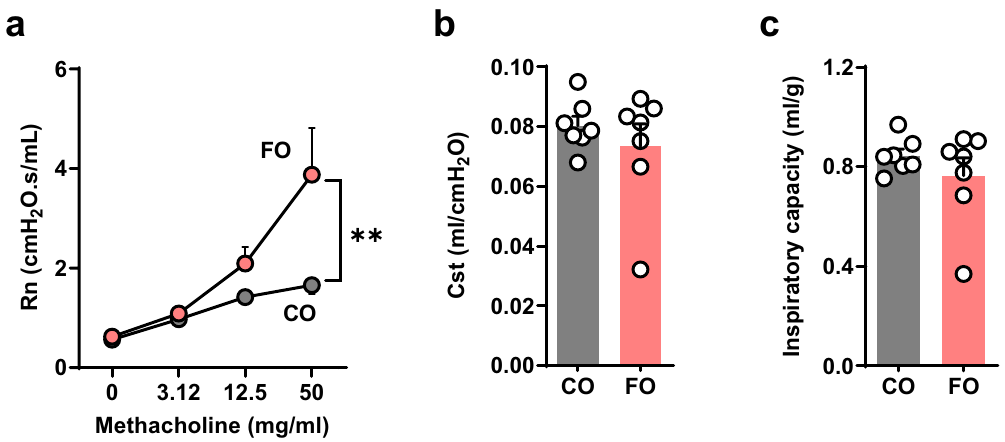
Figure 1. N-3 PUFA enriched diet induces innate airway hyperreactivity. BALB/c mice were fed a fish oil diet (FO) or an isocaloric control diet (CO) for 8 weeks. Pulmonary function testing was performed on anaesthetized and tracheotomized mice using a mouse pulmonary function system (Scireq). ( a ) Airway resistance (Rn) with increasing doses of methacholine. ( b ) Static compliance (Cst). ( c ) Inspiratory capacity (IC). Data are means ± SEM of 7 animals per group. **p < 0.001. Shown are results of ANOVA (Rn) or unpaired T-test (Cst,